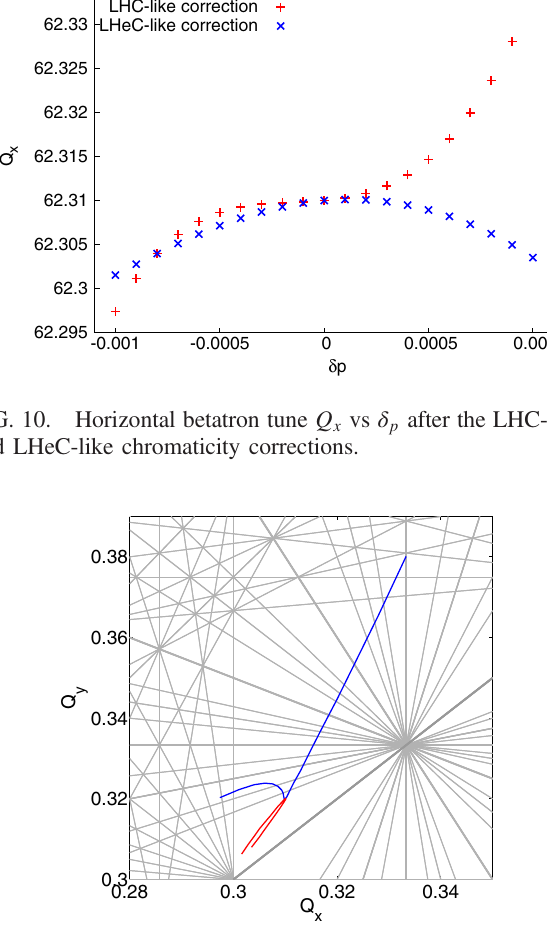
FIG. 11. Horizontal ( Q x ) and vertical ( Q y ) betatron tunes within the momentum range δ p ¼ (cid:3) 0 . 001 for beam 2 plotted on the resonance map up to the 10th order for the LHC-like (blue) and LHeC-like (red) chromaticity